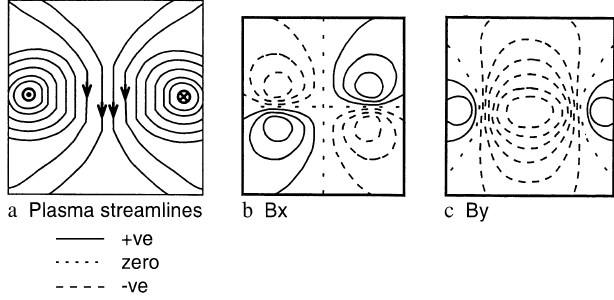
Fig. 6. a Plasma streamlines associated with a pair of field aligned currents, marked by up-arrow and down-arrow symbols. b and c show the B and B magnetic field perturbations associated with the x y streamlines in a (after Wei and